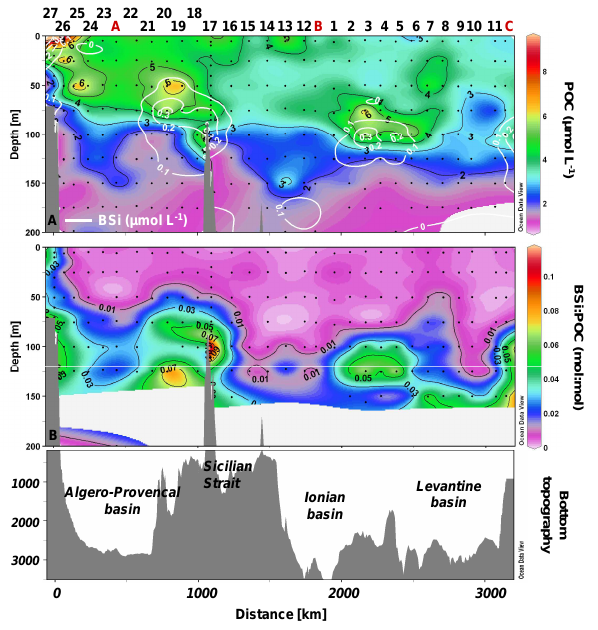
Fig. 11. Integrated biogenic silica stocks (mmolm − 2 ) over 0– 150m (with exceptions indicated by a red star) for the PROSOPE cruise (A) and the BOUM cruise (B) along a West-East gradient. In- tegration depths at PROSOPE stations 1 and 2 were 100 and 110m respectively, while integration depths at BOUM stations 17 and 27 were 118 and 100m